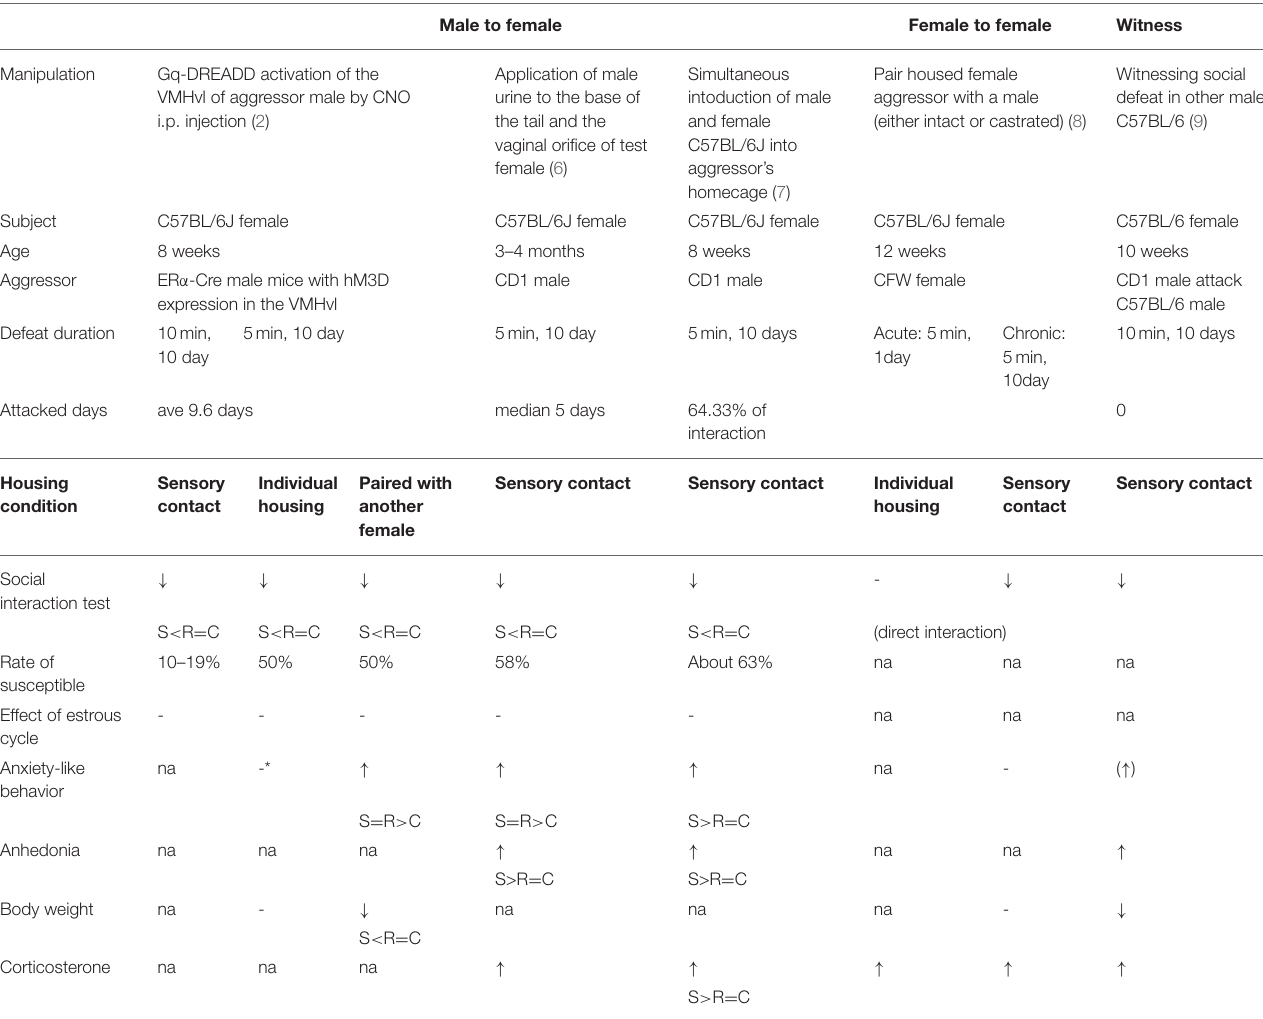
TABLE 1 | Female social defeat stress mouse models. Male to female Female to female